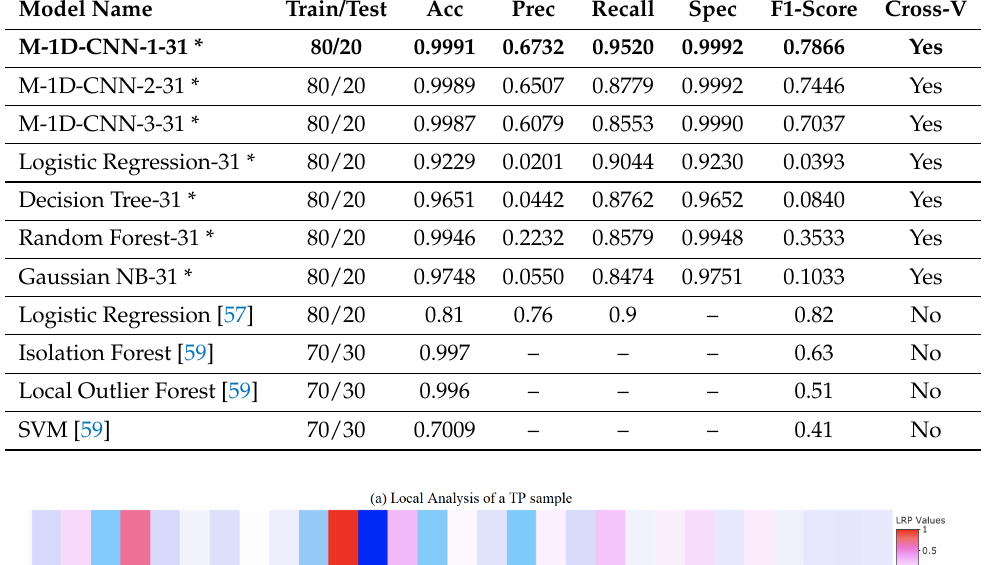
Table 4. Comparison of our 1D-CNN (with *) performance on CCFDD against published results.